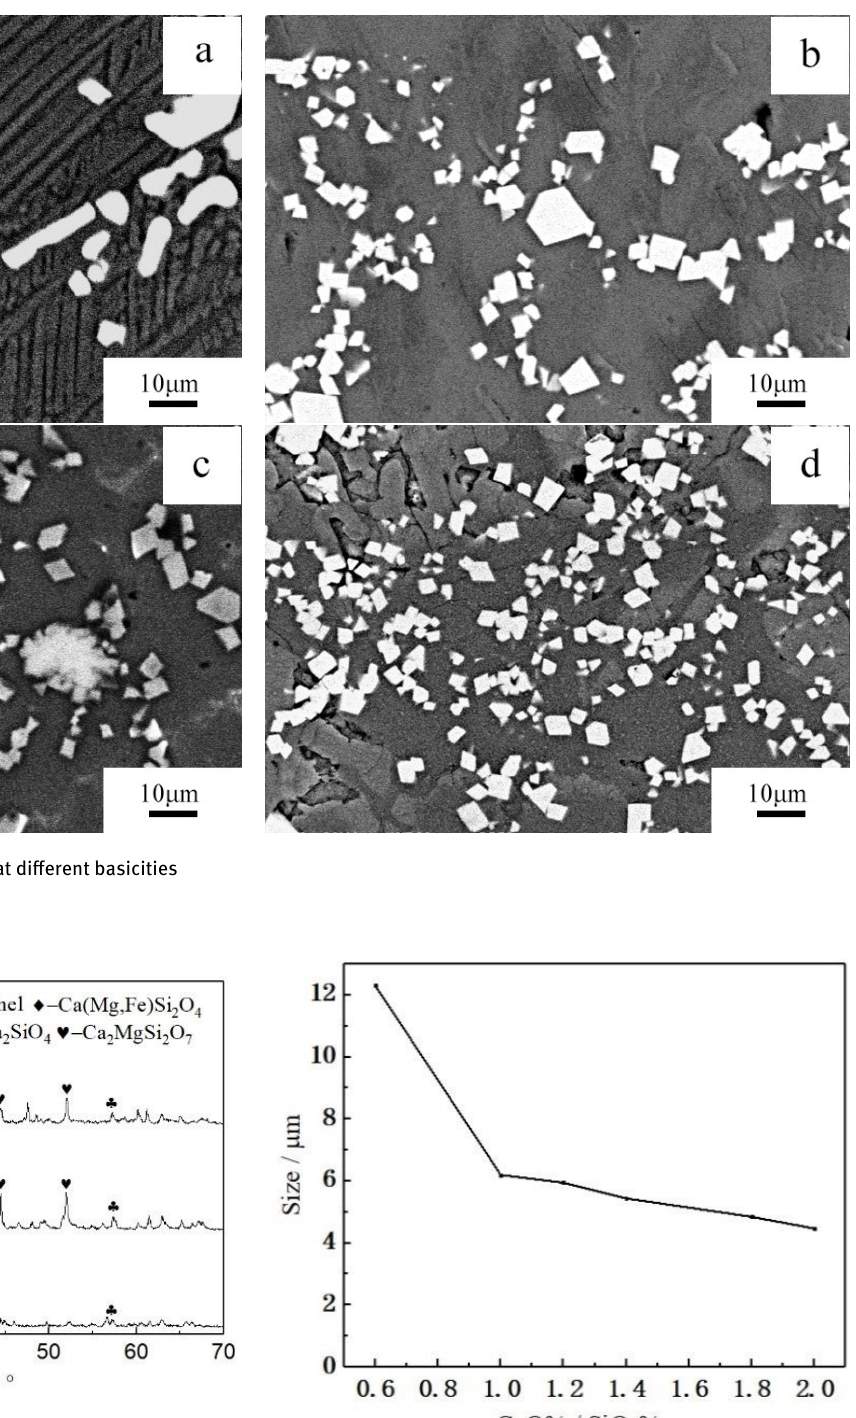
than 1.0. There is a great drop in the spinel crystal size from 12.30 µm down to 6.22 µm that constitutes 49.43% when ba- sicity increases from 0.6 up to 1.0. The curve trend is